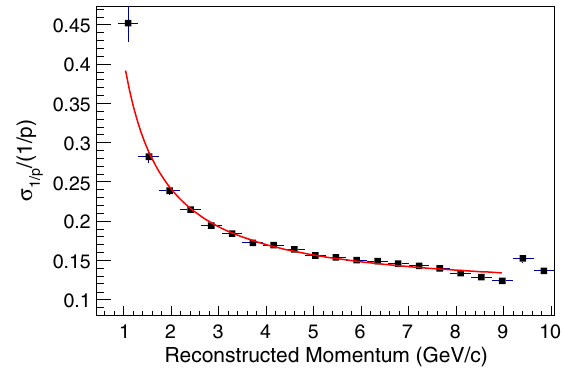
FIG. 4. Momentum resolution from the muon track reconstruc- tion. The parametrization of the resolution measured from the simulation is shown with the red solid